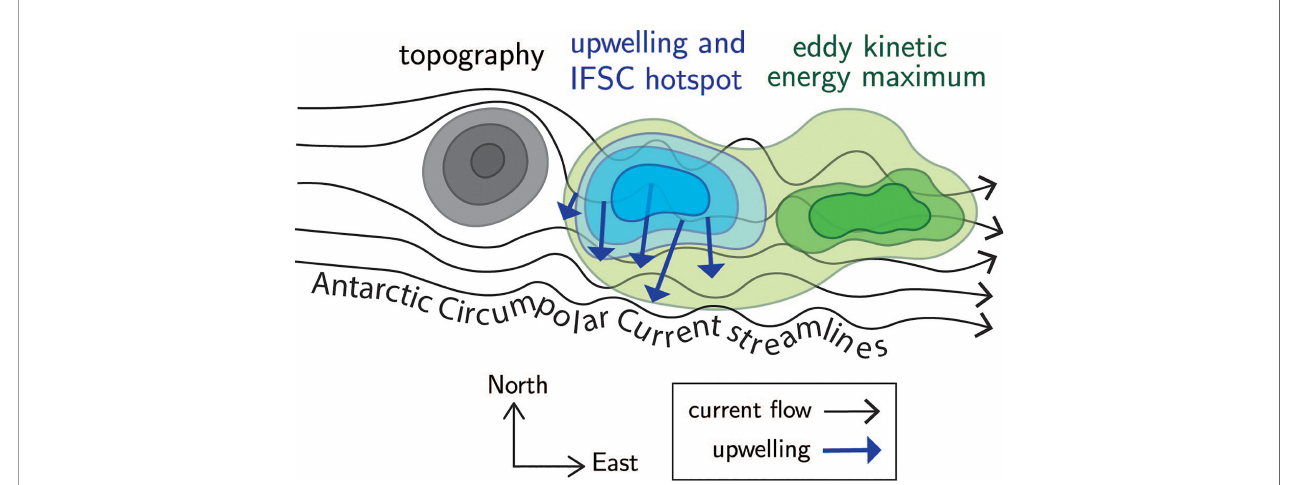
FIGURE 11 | Schematic of upwelling hotspot dynamics, from a bird ’ s eye view perspective. The Antarctic Circumpolar Current (black arrows) becomes unstable downstream of topographic obstacles (grey contours), resulting in an upwelling and baroclinic conversion (IFSC) hotspot (blue arrows and contours). The eddy kinetic energy (green contours) is also enhanced downstream of topography but is maximised further